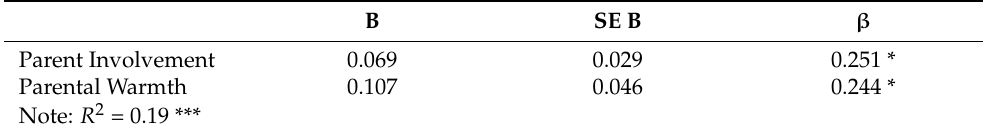
Table 3. Regression for boys—achievement.